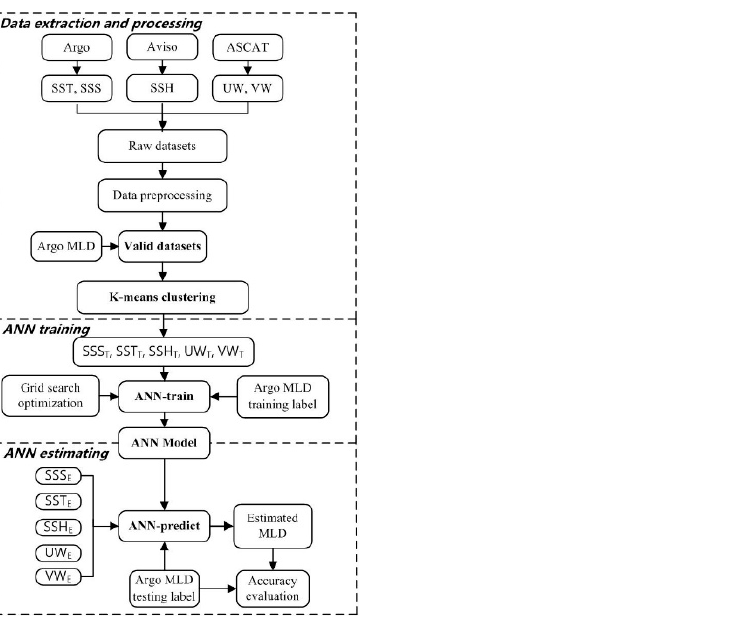
Figure 1. Flowchart of the methodologies used in this research.